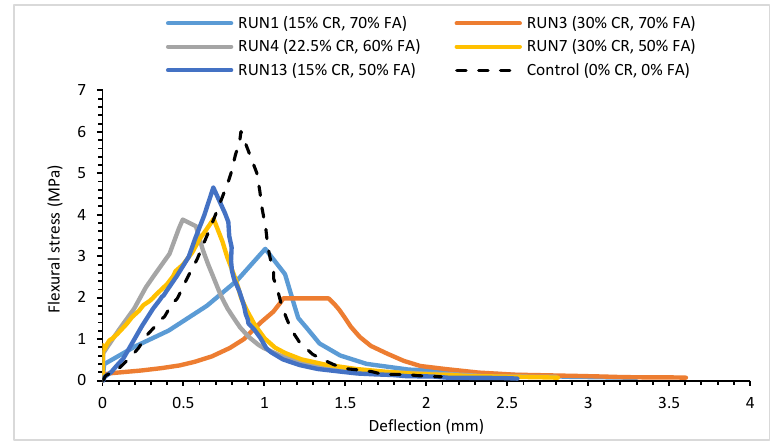
Figure 10. Flexural stress–strain graph for certain HVFA–CRC mixes. 2. In the ANOVA result for splitting tensile strength, the A term represents CR not PVA as corrected in the table below. Table 4. Result of the ANOVA.